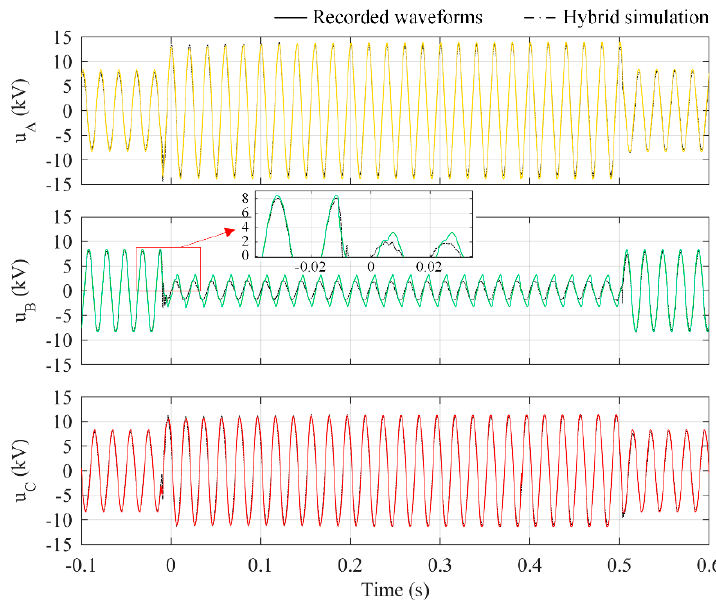
Figure 4. Waveform comparisons between field-recorded fault voltages and hybrid simulation voltages acquired at 10 kV BUS1. Table 2. Accuracy evaluation results of case